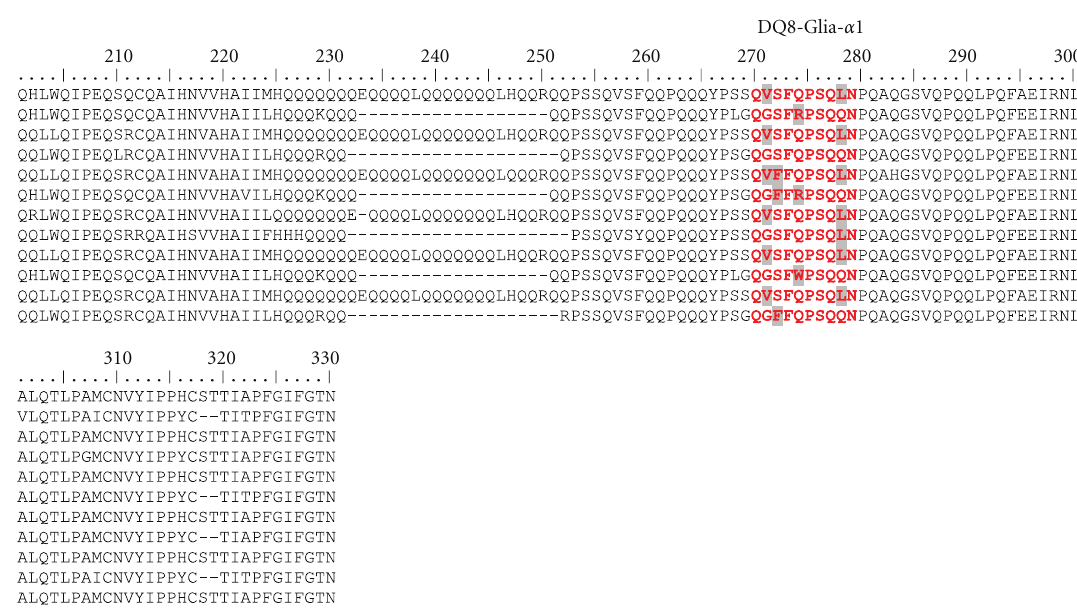
Figure 2: Alignment of deduced L and S α -gliadin isoforms of each wheat accession under study. The five epitopes known to be involved in CD, p31–49 (LGQQQPFPPQQPYPQPQPF), DQ2-Glia- α 1 [P(F/Y)PQPQLPY], DQ2-Glia- α 2 (PQPQLPYPQ), DQ2-Glia- α 3 (FRPQQPYPQ), and DQ8-Glia- α 1 (QGSFQPSQQN) are shown in red. In light grey: aminoacid substitution; hyphen and light grey: aminoacid deletion. For each α -gliadin isoform the signal peptide is in light blue.